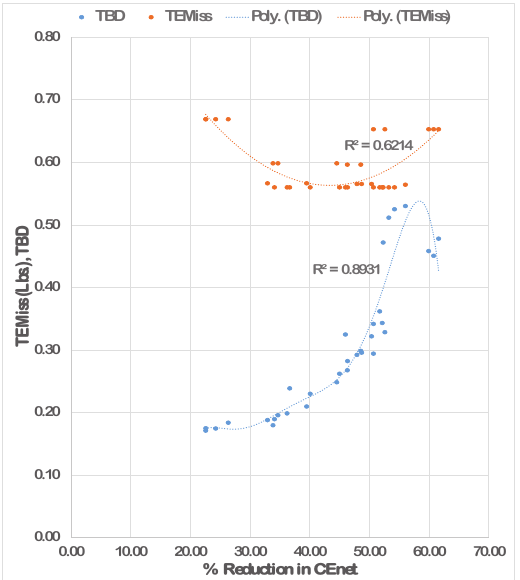
Figure 18. Relation between % Reduction in CEnet, TBD and TEMiss for eco-efficient